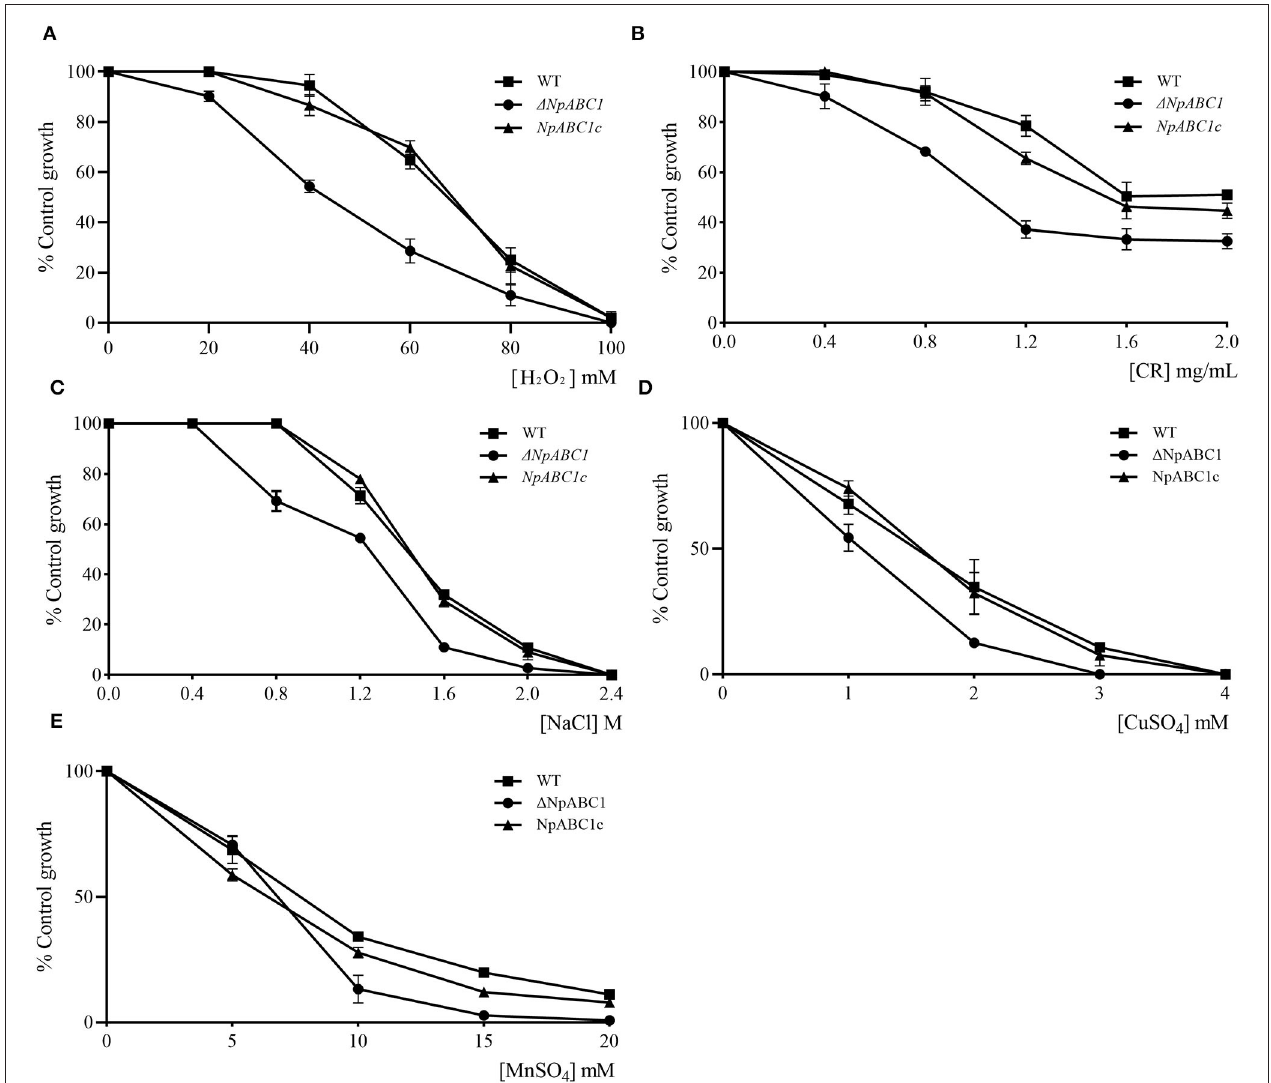
FIGURE 9 | Effect of H 2 O 2 , CR, NaCl, and metal in N. parvum strains. (A) hydrogen peroxide, (B) Congo Red, (C) Sodium chloride, (D) copper, or (E) manganese. WT, wild-type strain ( (cid:4) ); ∆ NpABC1 , deletion mutant strains (•); NpABC1c , complementary strains ( N ). The X-axis represents the final concentration of the substance added to the PDA medium. The Y-axis (% control growth) represents the ratio of the colony diameter of the treatment group to the negative control group. Data of diameter were harvested after 3 days of growth. Culture conditions: 25 ◦ C light–dark alternation for 12h.